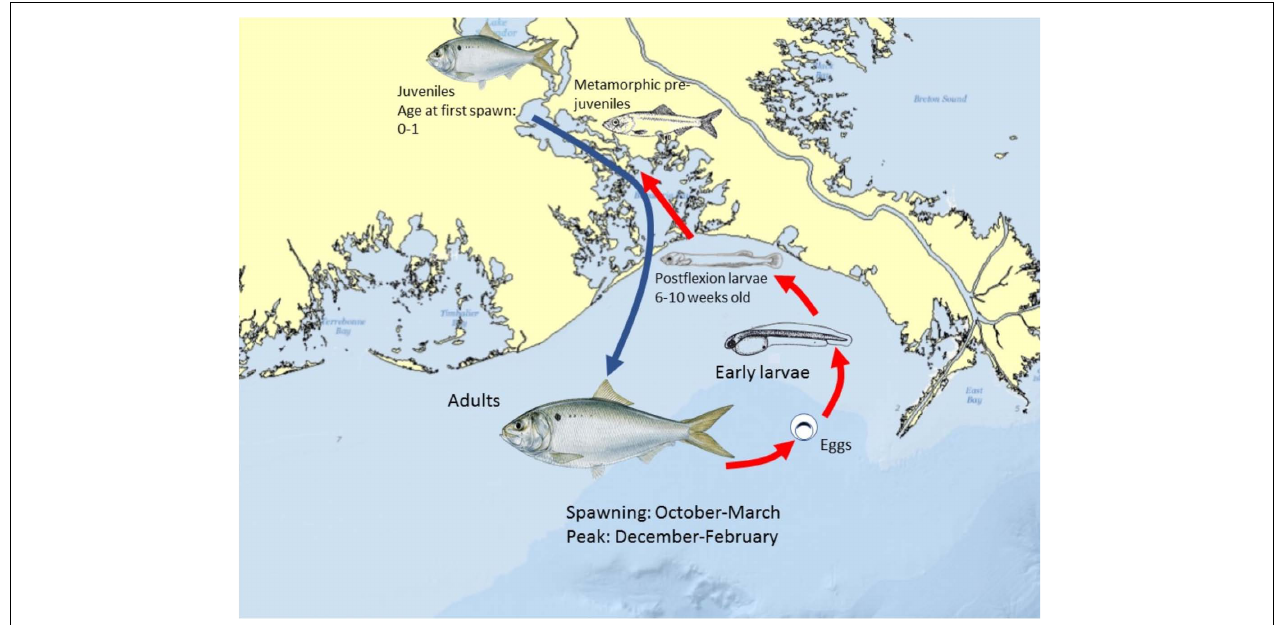
FIGURE 13 | Schematic of the spawning and early life history of Gulf Menhaden in the northern GoM. Peak spawning occurs between December and February, with growth to the advanced larval largely completed by early-mid May, prior to the earliest dates Deepwater Horizon oil came ashore in coastal Louisiana. Menhaden color graphics with permission of the artist Diane Rome Peebles R (cid:13)